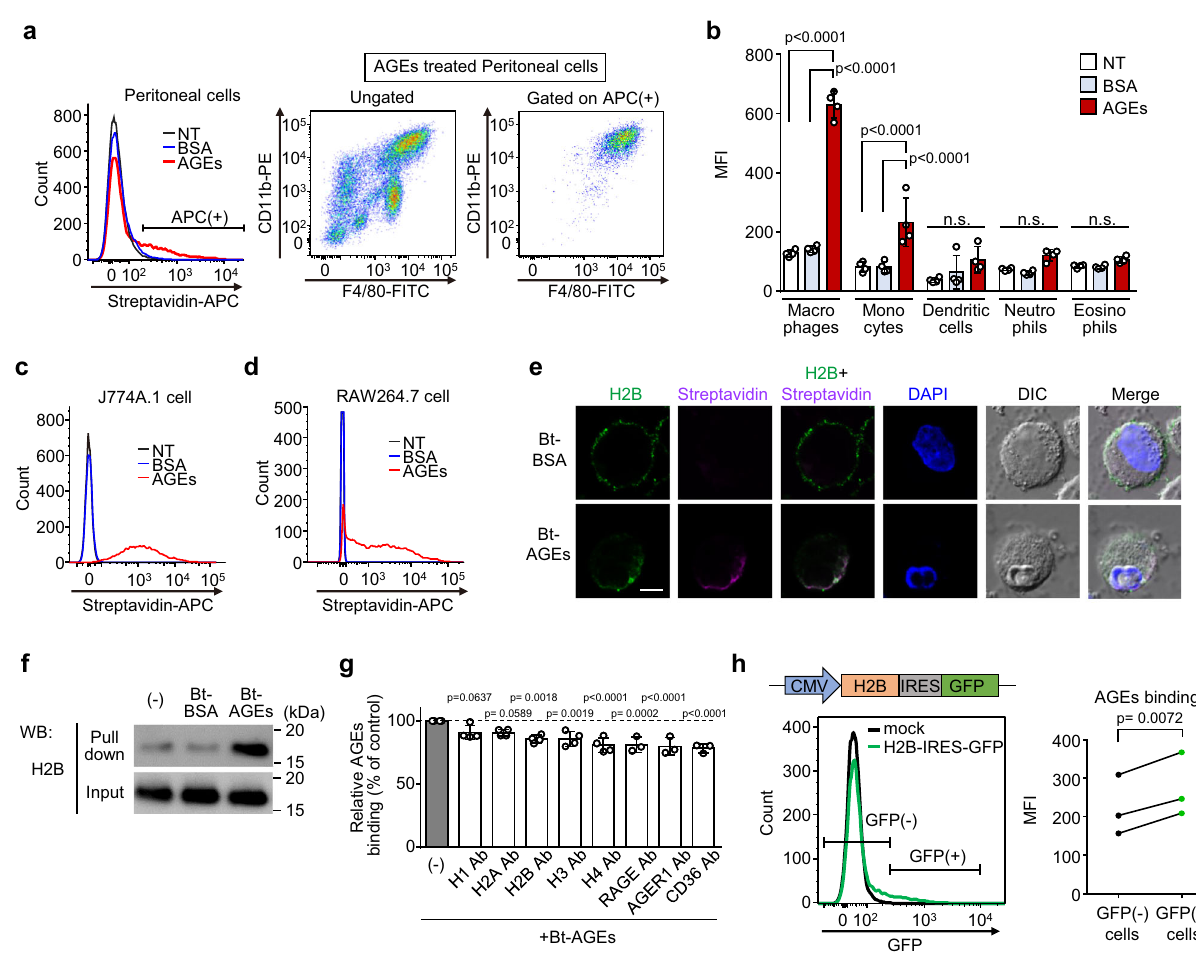
Fig. 3 Histone-dependent binding of AGEs to macrophages. a Binding of AGEs to mouse peritoneal cells. Left histogram, peritoneal cells were incubated alone (black line) or with Bt-BSA (blue line) or Bt-AGEs (red line), stained with streptavidin-APC, and analyzed by fl ow cytometry. Right two panels, Stained cells with CD11b and F4/80 were analyzed without or with gating on APC ( + ). b Cell-type speci fi city for AGEs binding. Peritoneal cells were incubated alone (NT) or with Bt-BSA (BSA) or Bt-AGEs (AGEs) and stained with streptavidin-BV421. Macrophages, Monocytes, Dendritic cells, Neutrophils, Eosinophils were gated and the bindings of Bt-BSA or Bt-AGEs were expressed as median fl uorescent intensity (MFI) of BV421. Data are mean ± S.D. ( n = 4, biologically independent experiments). Tukey – Kramer tests (two-sided), n.s. not signi fi cant ( p > 0.05). c , d Binding of AGEs to J774A.1 ( c ) and RAW264.7 ( d ) cells. The cells were incubated alone (black line) or with either Bt-BSA (blue line) or Bt-AGEs (red line) and analyzed by fl ow cytometry. e Colocalization of H2B with AGEs. J774A.1 cells were treated with either Bt-BSA or Bt-AGEs and stained with anti-H2B antibody and streptavidin-alexa568. Scale bar, 10 µ m. Representative image of three independent experiments. f Pull-down assay for the detection of H2B as a cell- surface AGEs-binding protein. J774A.1 cells were incubated with Bt-BSA or Bt-AGEs and then incubated with DTSSP. The detergent-resistant membrane fractions were subjected to pull-down, and the resulting precipitates were detected by western blotting using an anti-H2B antibody. Representative image of two independent experiments. g Inhibition of AGEs binding by anti-histones or anti-AGEs receptors antibodies. Cells were preincubated with antibody against histone H1, H2A, H2B, H3, H4, RAGE, AGER1, or CD36 prior to the treatment with Bt-AGEs. Relative AGEs bindings were determined by the MFI of APC. Data are mean ± S.D. ( n = 4 for histone antibodies and n = 3 for known AGEs receptors antibodies, biologically independent experiments). Dunnett ’ s test (two-sided), relative to the control. h Effect of H2B overexpression on AGEs binding. J774A.1 cells were transfected with a bicistronic construct encoding H2B followed by IRES driving the translation of GFP (upper left panel) and the binding of Bt-AGEs was analyzed ( n = 3, biologically independent experiments). Paired t test